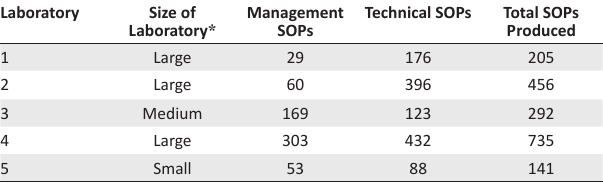
FIGURE 3: Average performance improvement of all laboratories across the 12 sections of the WHO AFRO SLIPTA checklist. TABLE 4: Number of standard operating procedures (SOPs) completed for the 5 laboratories.